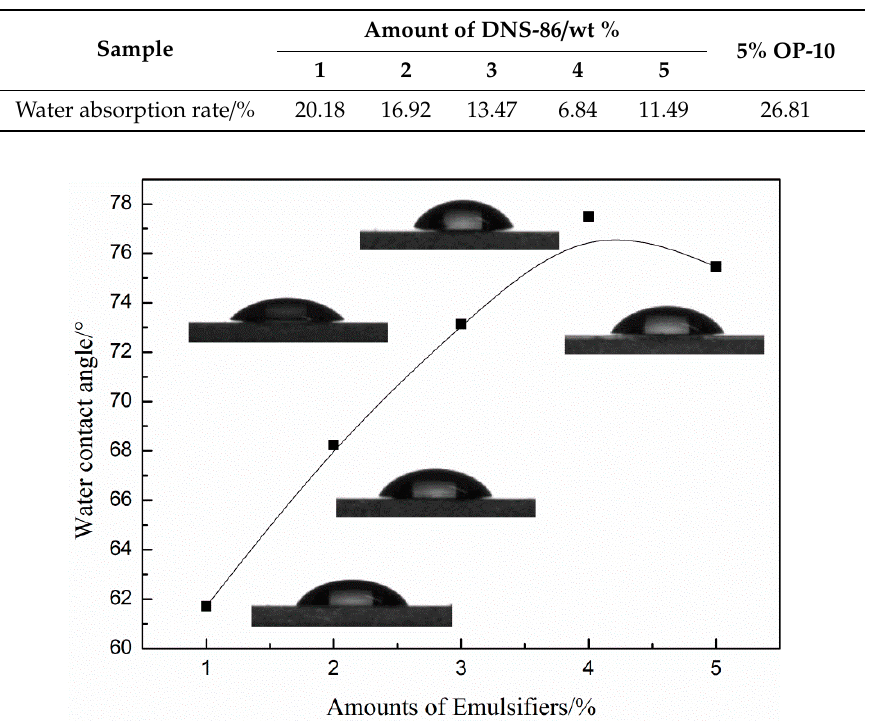
Figure 3. Effect of the DNS-86 amount on water contact angle of the latex film. Figure 3. E ff ect of the DNS-86 amount on water contact angle of the latex